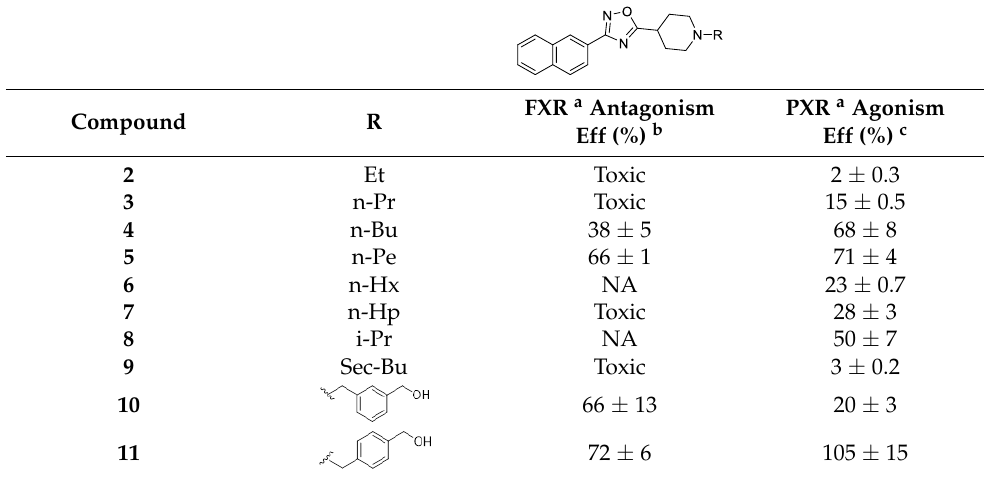
Table 1. Efficacy of compounds 2–11 towards FXR and PXR.